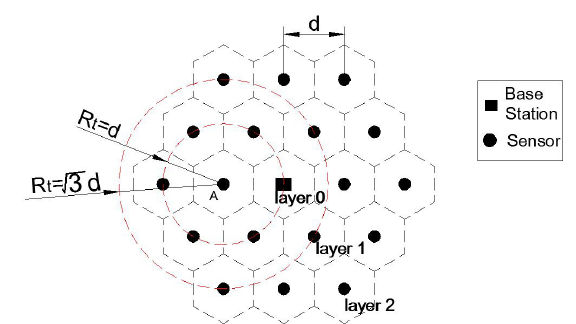
Figure 3. Data transmission analysis.